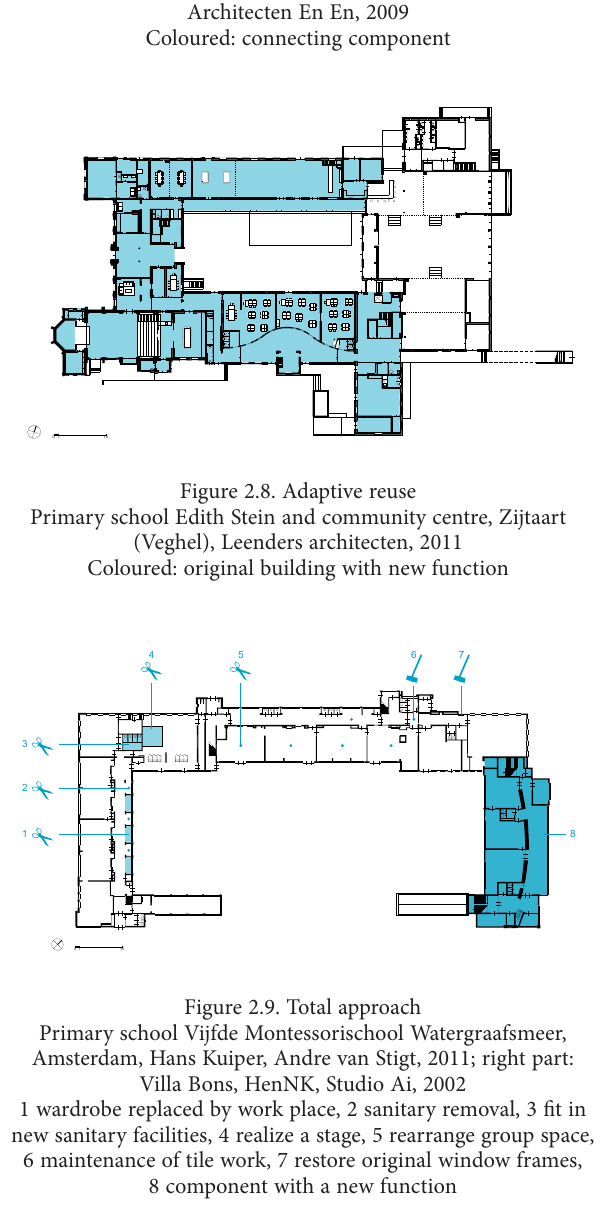
Figure 2.7. Put together